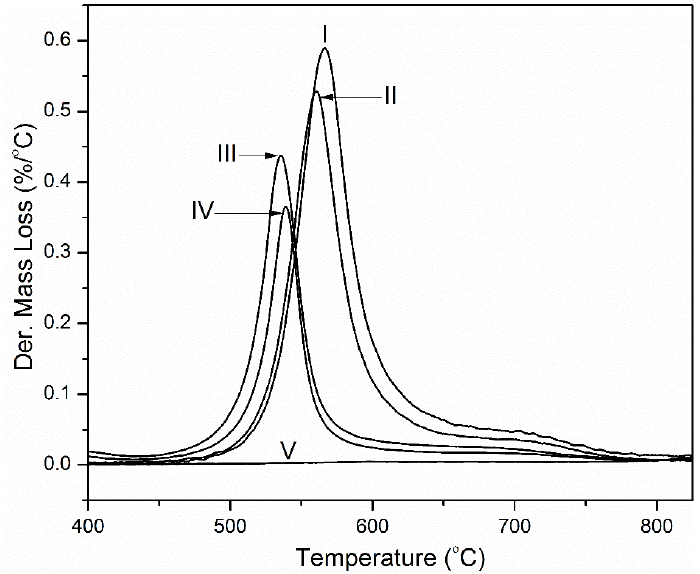
Figure 7. Derivative mass loss curves (I) PI, (II) PINGS -10, (III) PINGS-30, (IV) PINGS-50 and (V) Graphene (in nitrogen; β = 30 °C/min). Table 2. Summary data from derivative curves.